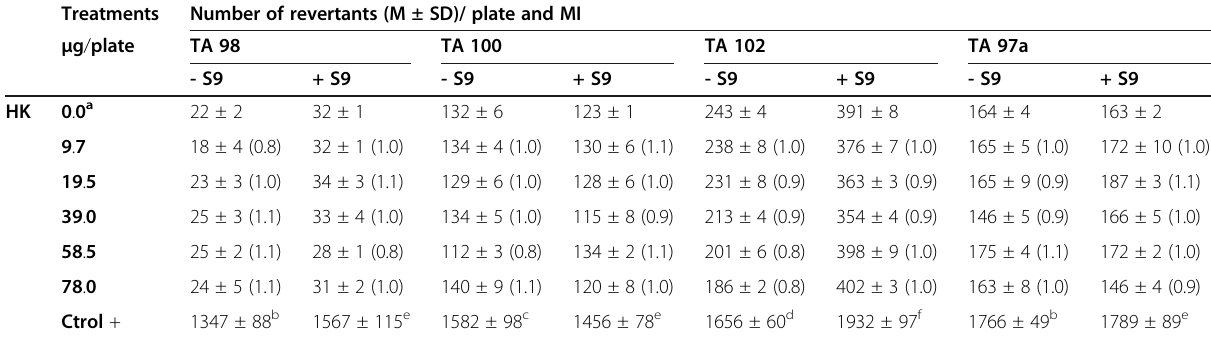
Table 2 Revertants/ plate, standard deviation and mutagenicity index (in brackets) for the strains TA98, TA100, TA102 and TA97a of S . typhimurium after treatment with various doses of HK, with (+S9) and without ( − S9) metabolic activation Treatments